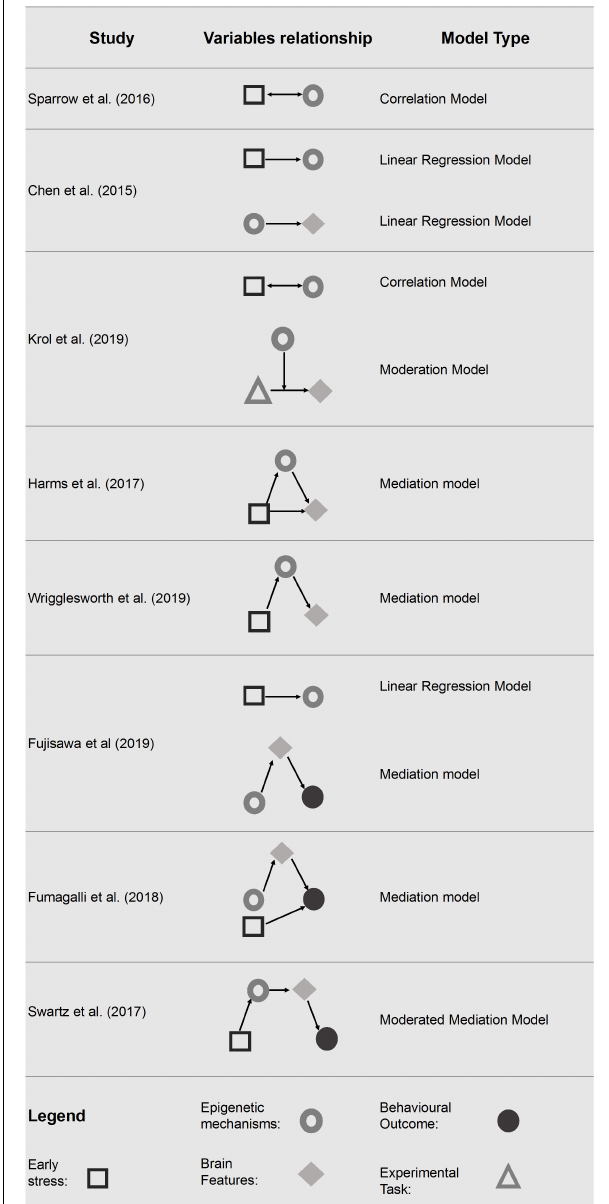
maternal anxiety on the neonatal epigenome among Met/Met compared to Val/Val carriers was